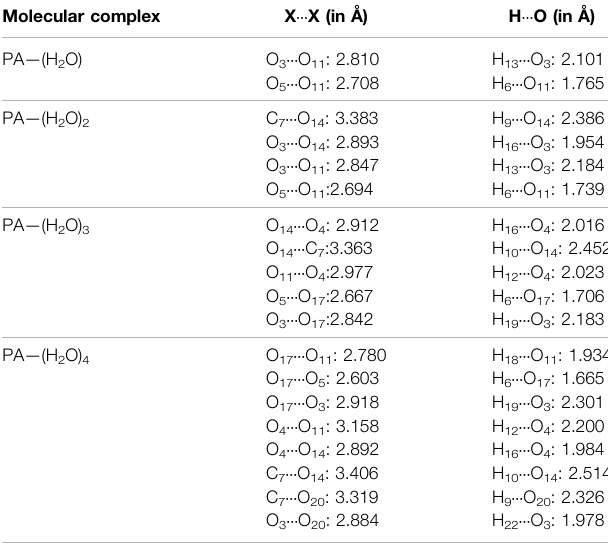
TABLE 1 | Intermolecular hydrogen bond lengths (X ··· X and X ··· H, where X = O and C) within the different molecular associations in the pyruvic acid – (H 2 O) n complexes. Molecular complex